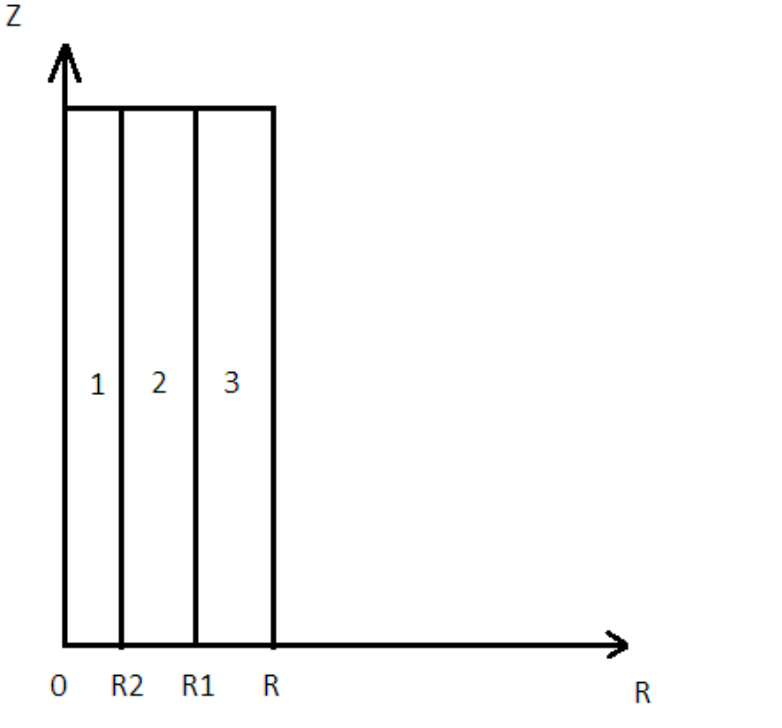
Figure 3. Geometry of the solution area.